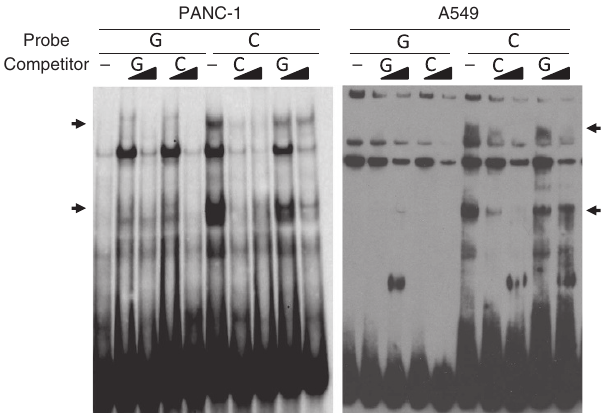
Figure 2 | rs36115365 preferentially binds a nuclear protein. Electrophoretic mobility shift assays (EMSA) with biotin-labelled oligonucleotides containing either rs36115365-C or rs36115365-G in pancreatic (PANC-1) and lung (A549) cancer cell line nuclear extracts. Two specific protein complexes bind the C allele of rs36115365 preferentially in both cell lines and are more strongly competed with unlabeled C probe as compared to unlabeled G probe. Unlabelled competitor was used at (cid:2) 10 and (cid:2) 100 (as indicated by gradient symbol). Arrows denote specific protein complexes bound by the C allele of